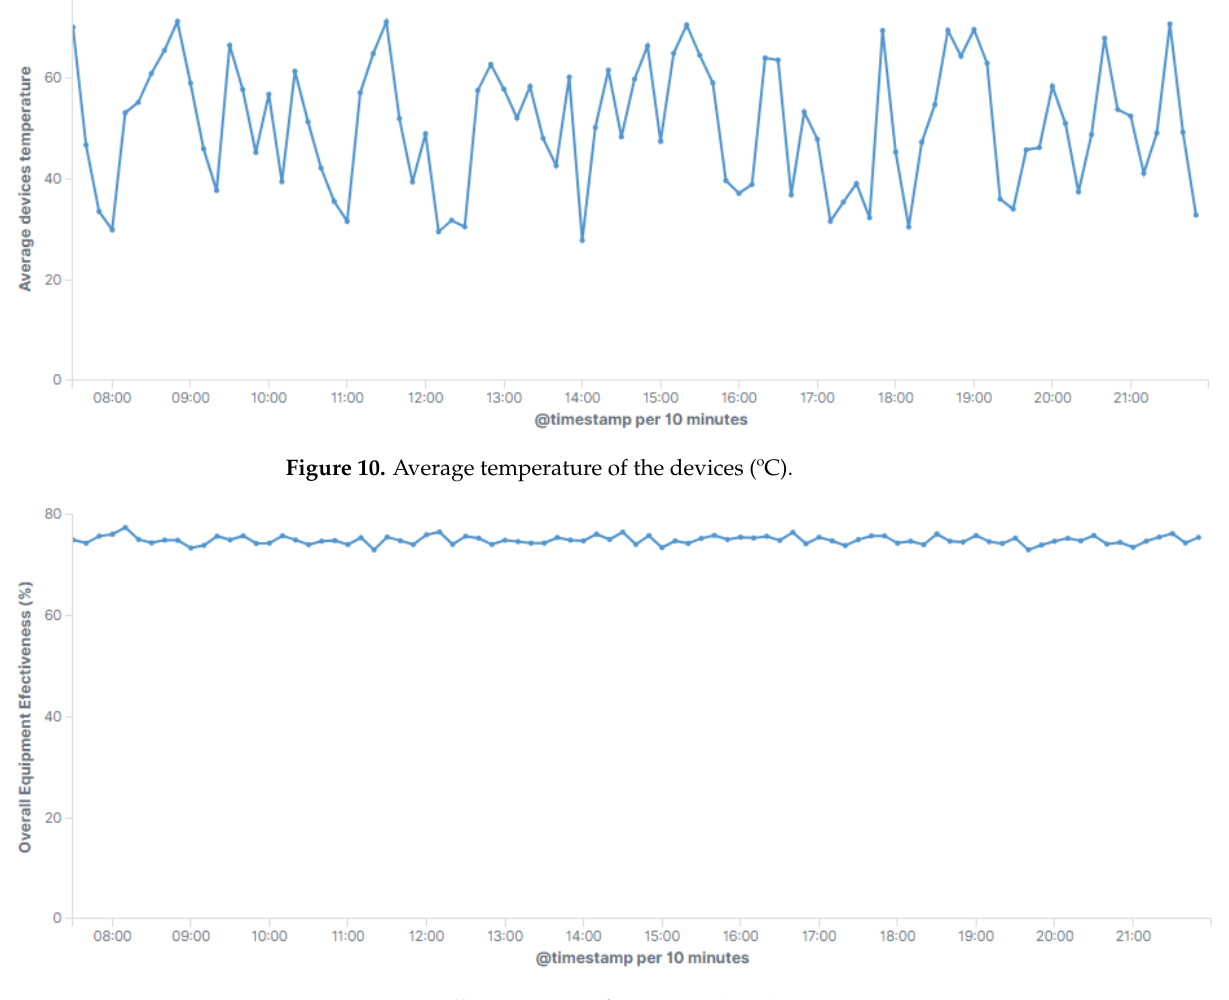
Figure 11. Overall Equipment Efectiveness